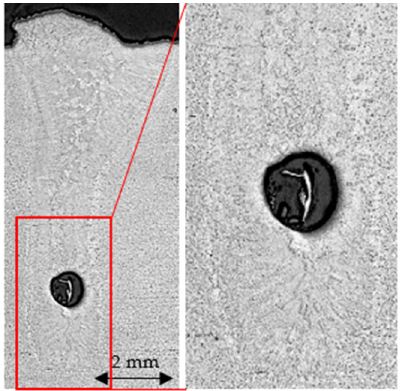
Figure 8. Exemplary microstructural surrounding of pores.